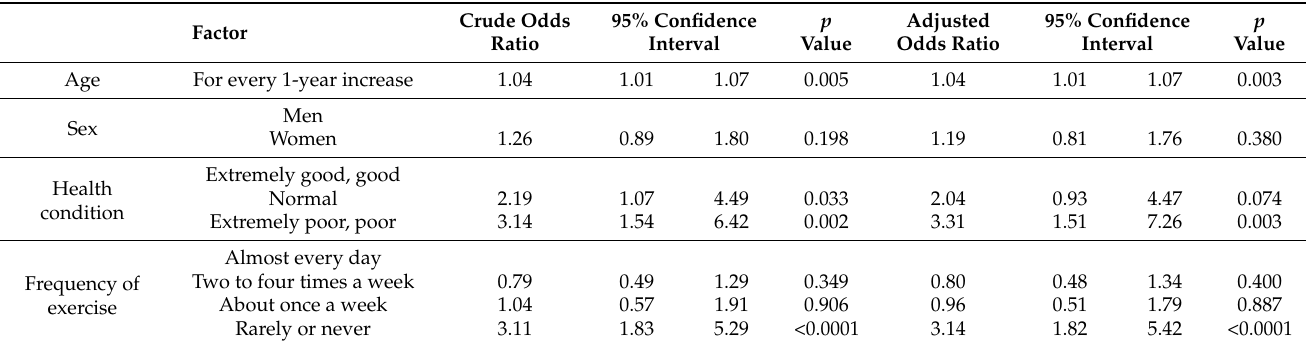
Table 6. Logistic regression analysis of the dependent variables for social nonparticipation in the activities of daily living (ADL) assistance required